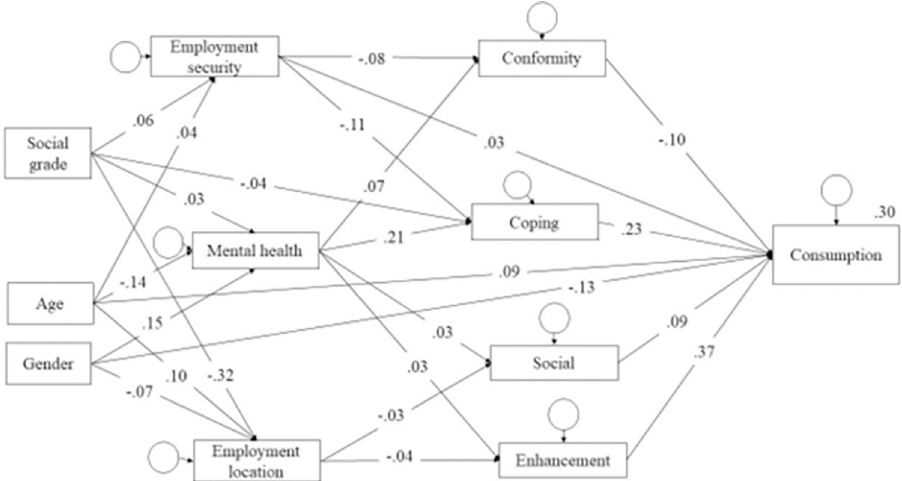
Fig 2. Final model diagram (values are standardised